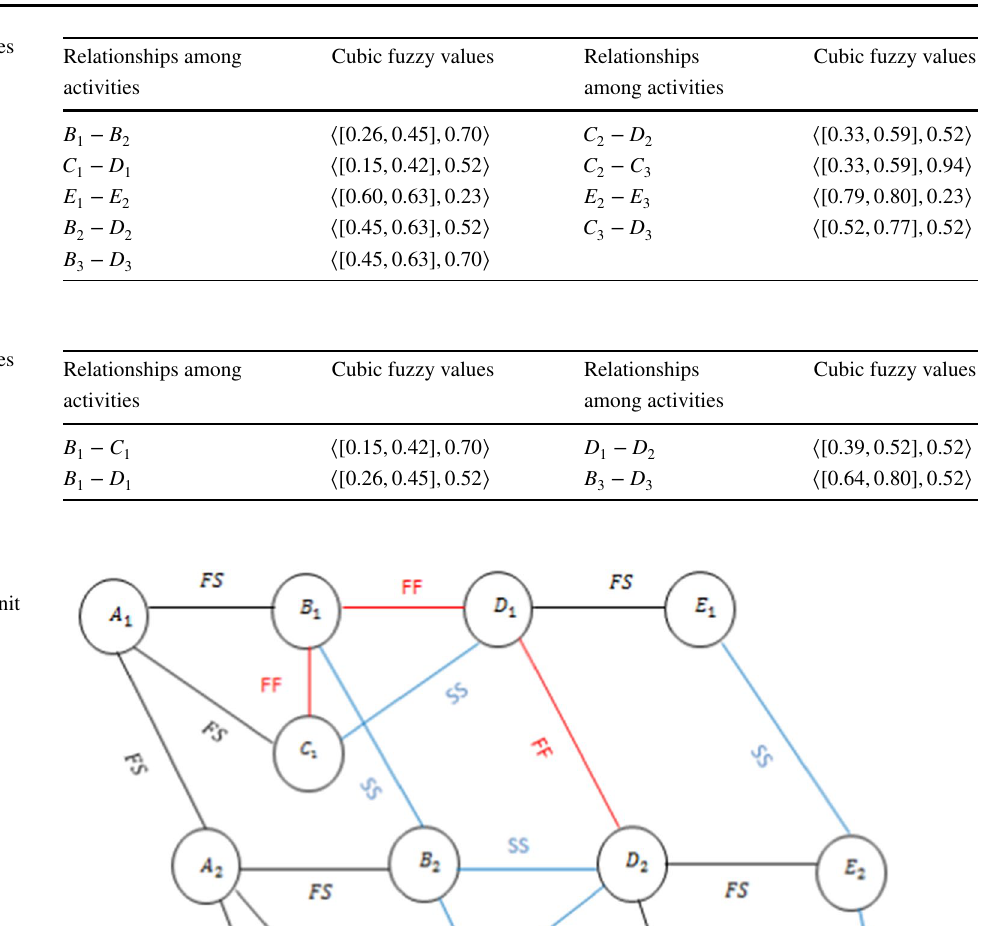
Table 5 The cubic fuzzy values of the relationships among activities relative to SS